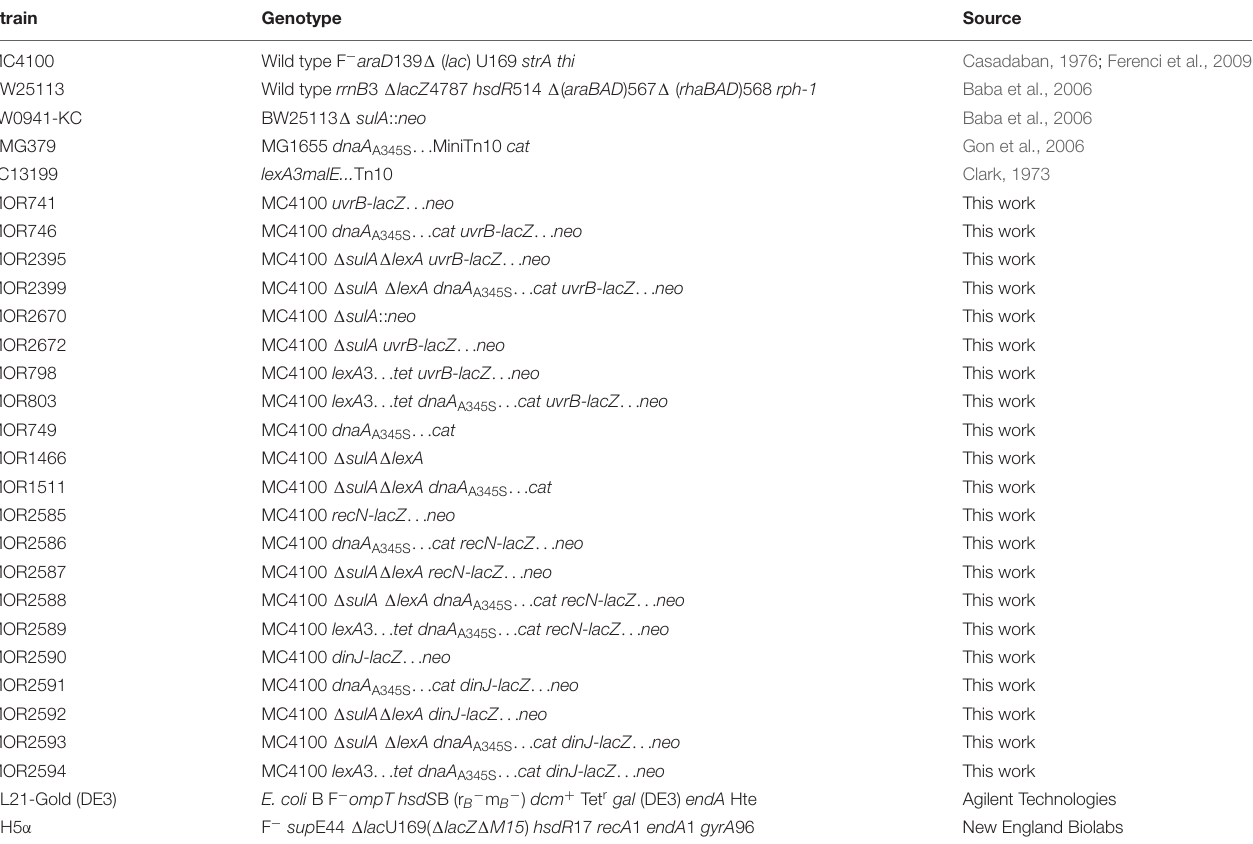
TABLE 1 | Bacterial strains. Strain Genotype